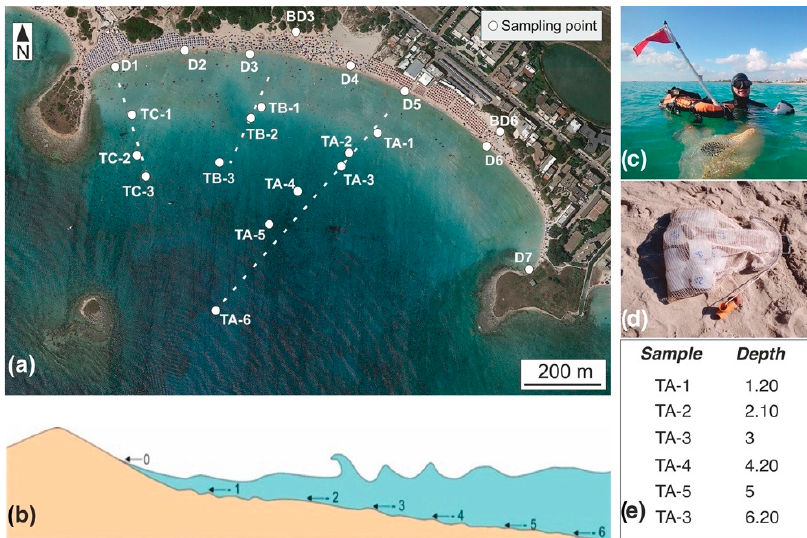
Figure 3. ( a ) Map showing the sampling collecting points. D = shoreline sample label, BD = foredune base sample, TA-1 = Sample collected along transect A at 1 m depth; ( b ) Ideal submerged beach profile (not in scale) with the indication of the sampling depths; ( c ) collection of shoreface samples; ( d ) small net for marine samples; ( e ) whiteboard for sample marine marks.